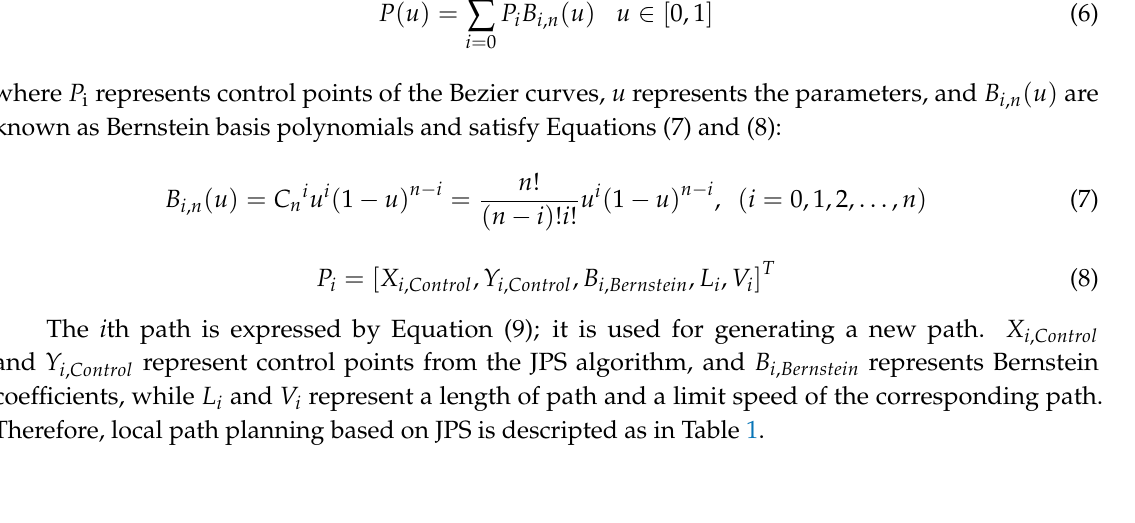
Figure 12. Jump Point Search (JPS) search procedure.